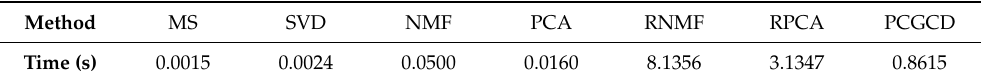
Table 4. Running time evaluation of different clutter removal methods in simulate GPR image.